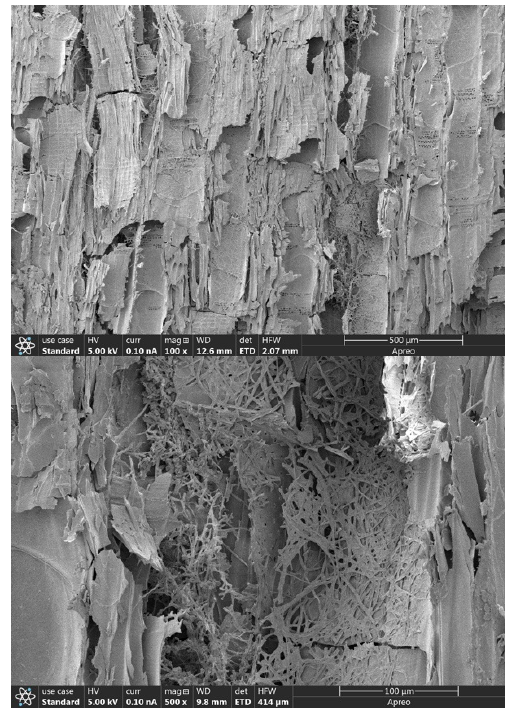
Figure 8. The internal morphology of the control group.